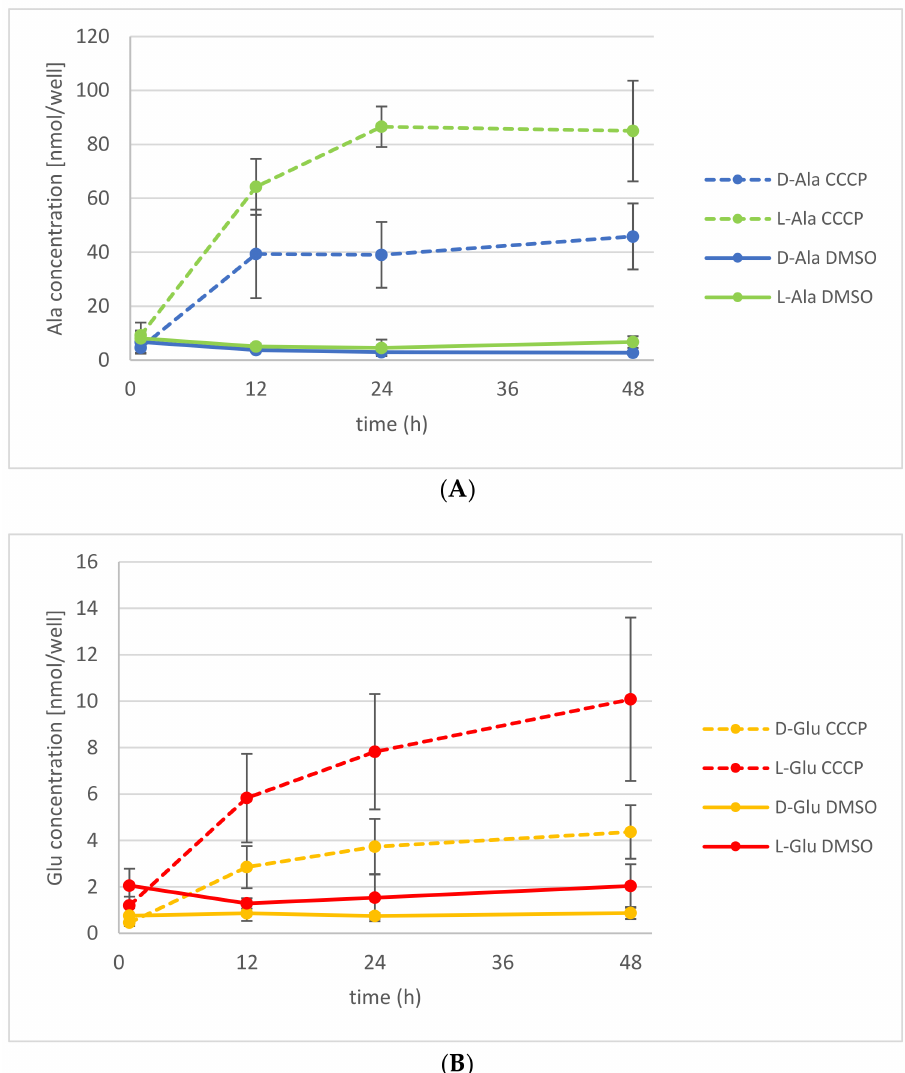
Figure 5. Release of D -/ L -Ala and D -/ L -Glu into the medium under CCCP treatment. Seedlings were treated with D -Ala and then transferred to fresh medium with 50 µ M CCCP (dashed line) or with the solvent of CCCP, dimethyl sulfoxide (DMSO; solid line). ( A ) The D -Ala (blue lines) and L -Ala (green lines) contents in the media were analyzed from 1 to 48 h after transfer. ( B ) In the same media, the D -Glu (yellow lines) and L -Glu (red lines) contents were also determined. Error bars: ±